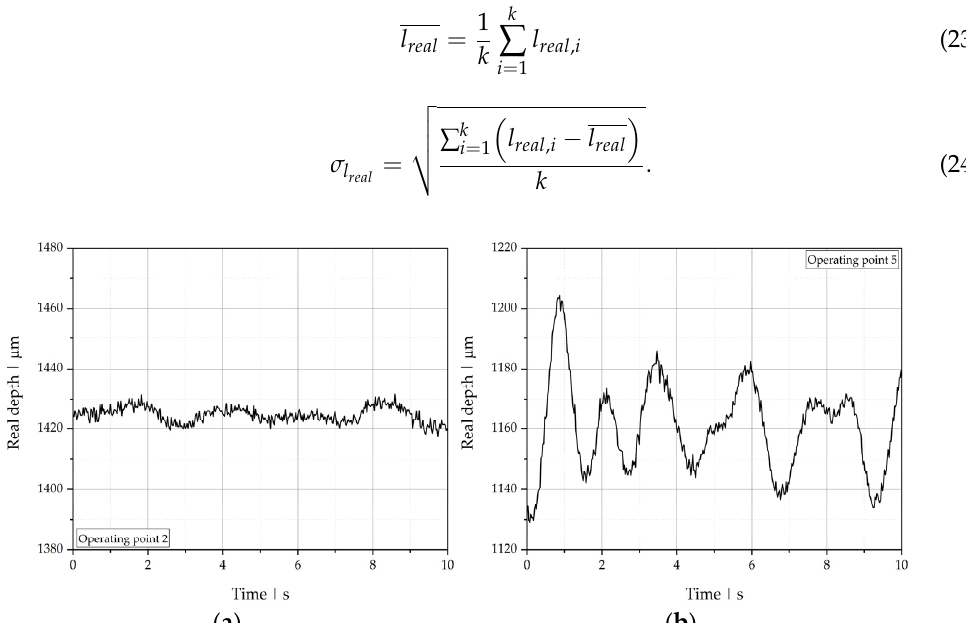
Figure 10. Real depth position of the polymer-polymer interface over time for ( a ) operating point 2 and ( b ) operating point 5. and ( b ) operating point 5.